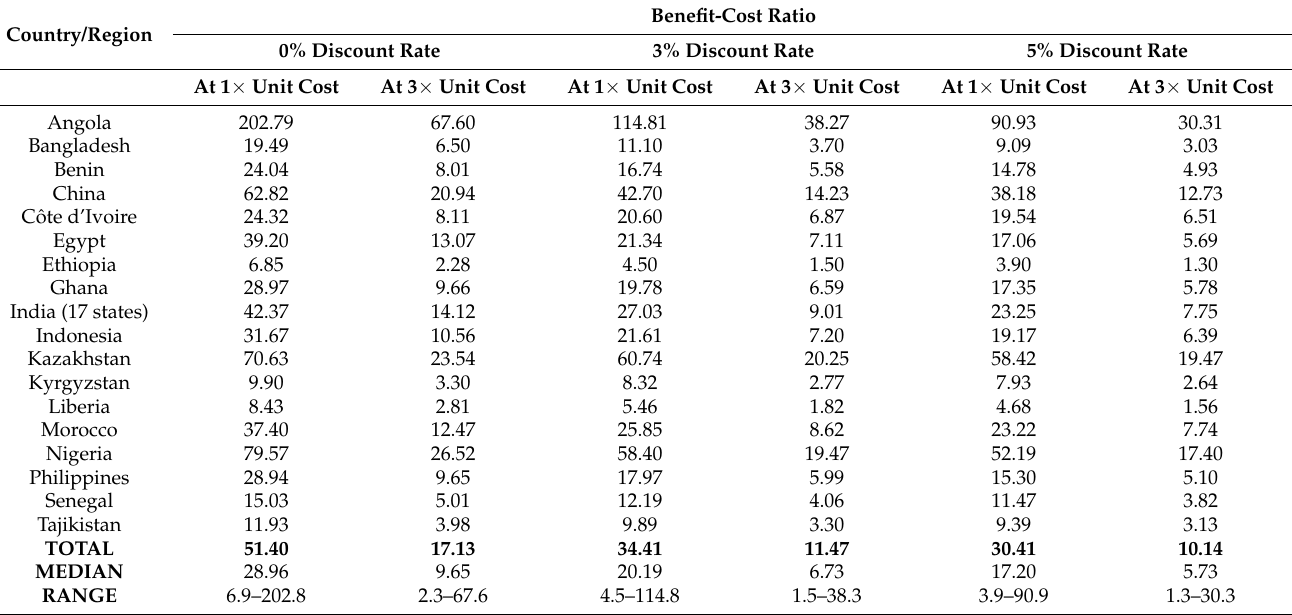
Table A4. Sensitivity analysis: cost–benefit ratio at 0%, 3%, and 5% and 1 × and 3 × unit cost (0.37 USD) at a national level. Country/Region